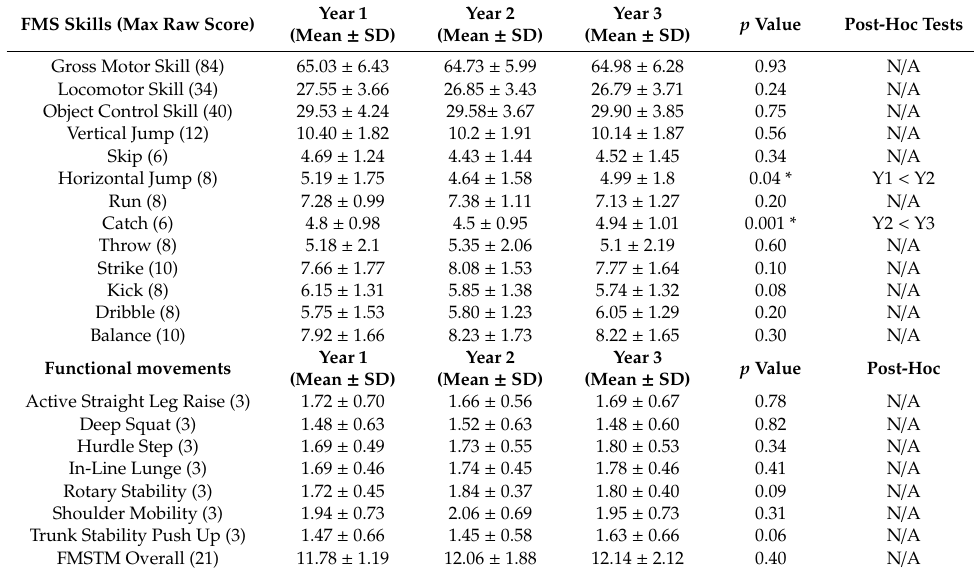
Table 1. Actual FMS and FMS TM proficiency by year group (ANOVA results).